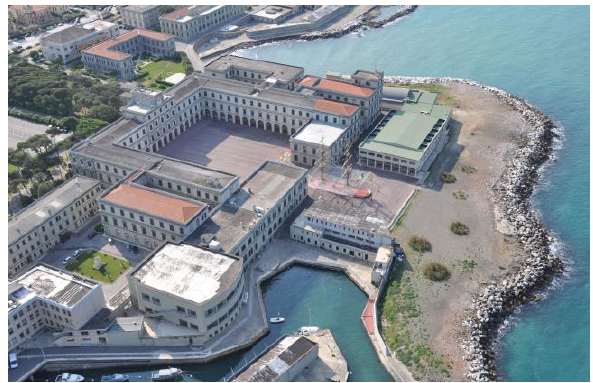
Figure 2 . The Navy Italian Academy, Livorno.